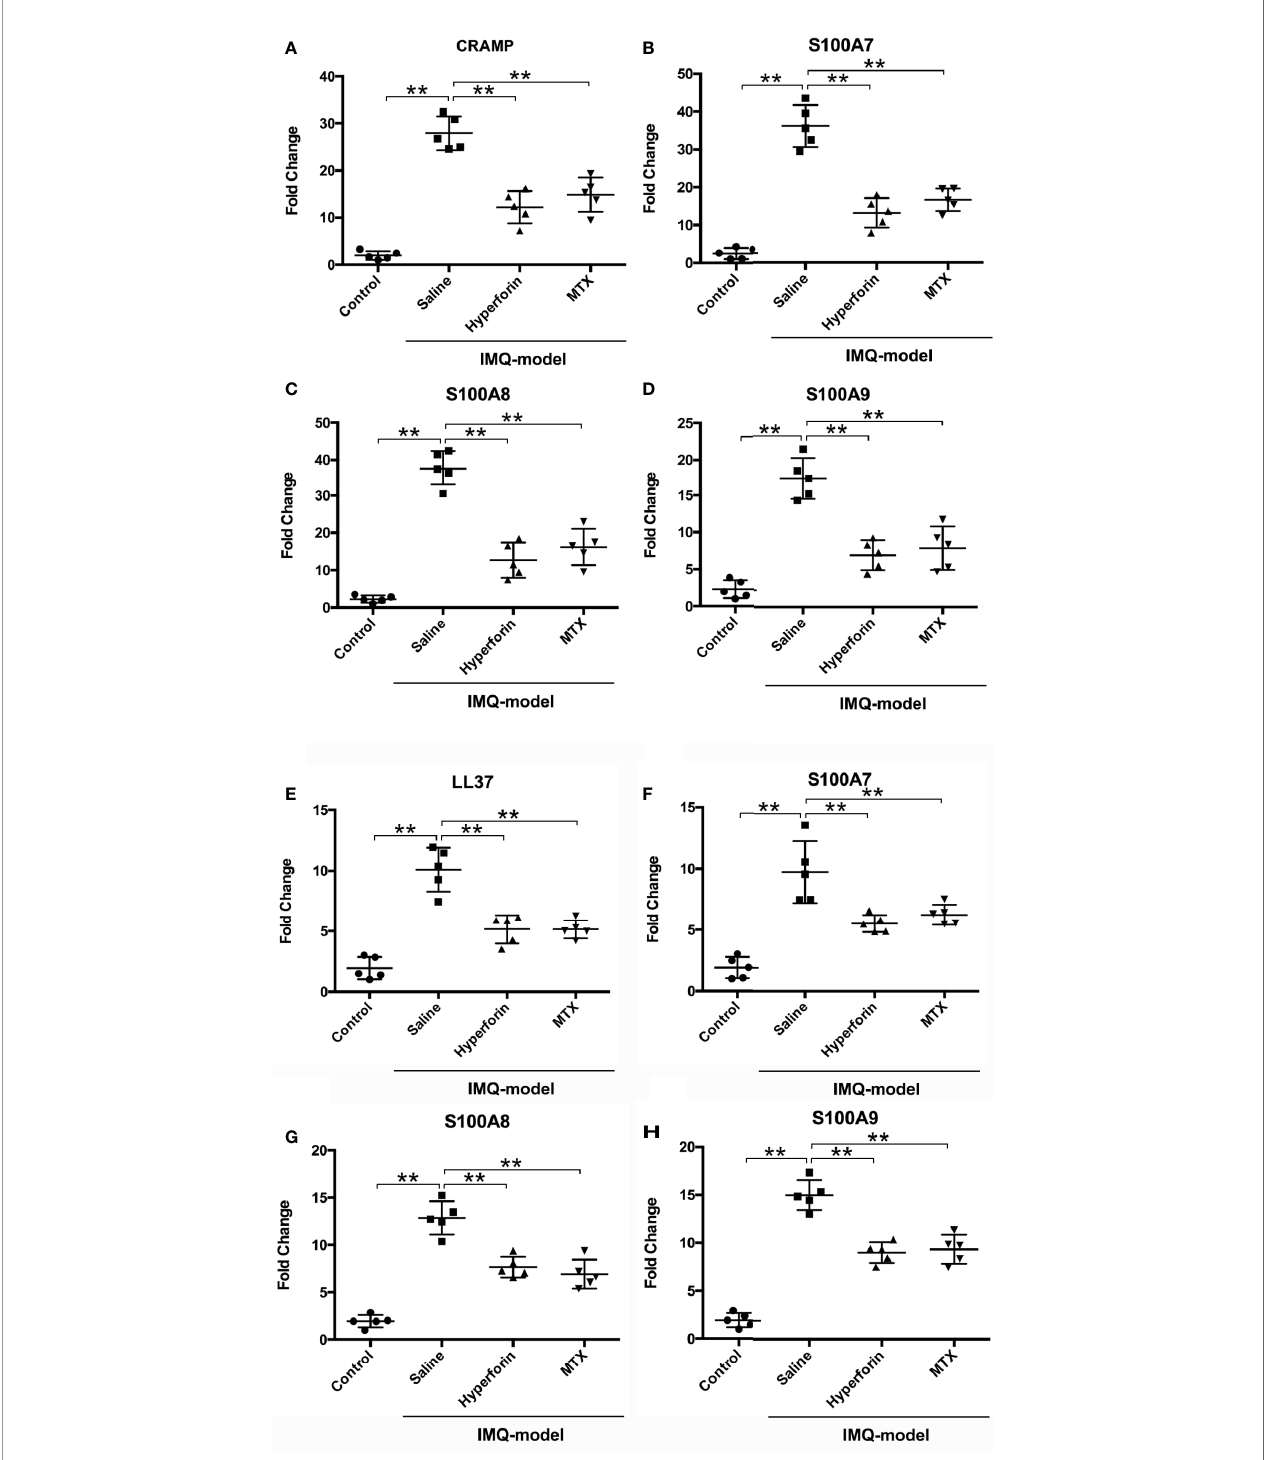
FIGURE 5 | Hyperforin downregulated the mRNA expression of AMPs in in skin of IMQ-induced mouse model and TNF- a stimulated HaCaT cells. The mRNA expression of AMPs in the skin lesion of mice model, CRAMP (A) , S100A7 (B) , S100A8 (C) , and S100A9 (D) . After pre-treatment with hyperforin, HaCaT cells were stimulated with TNF- a , and RT-qPCR was used to detect the effects of hyperforin on the mRNA expression of LL37 (E) , S100A7 (F) , S100A8 (G) , and S100A9 (H) . Data are expressed as fold induction of relevant mRNA sequences compared to untreated controls. Data represent mean ± SEM from at least three independent experiments performed in triplicates; **P < 0.01 vs model